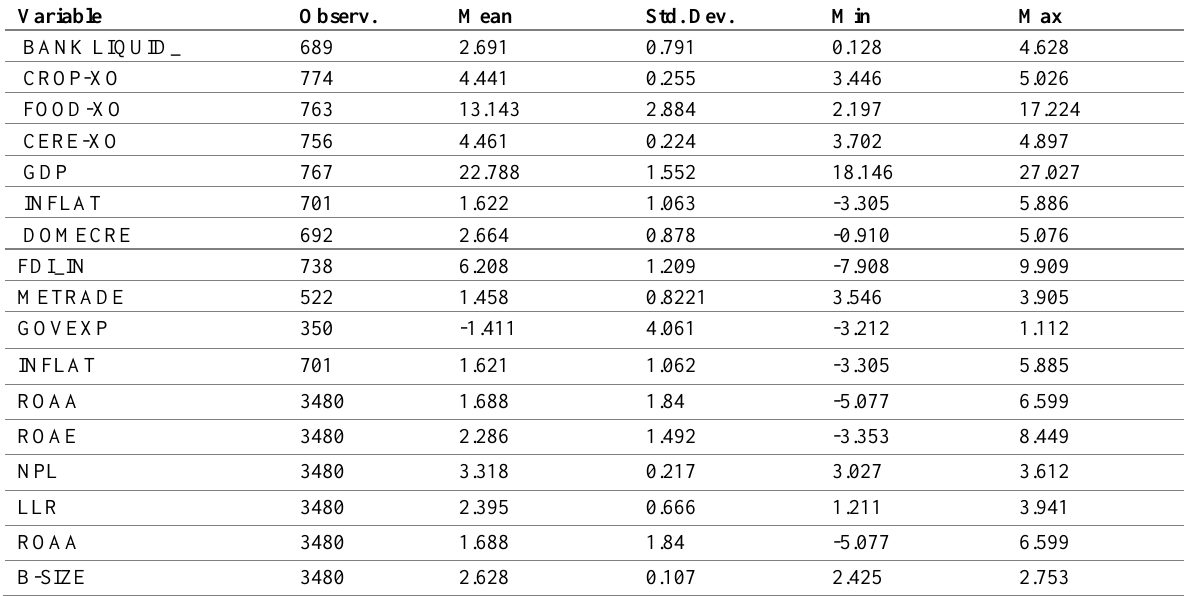
Table 3: Descriptive